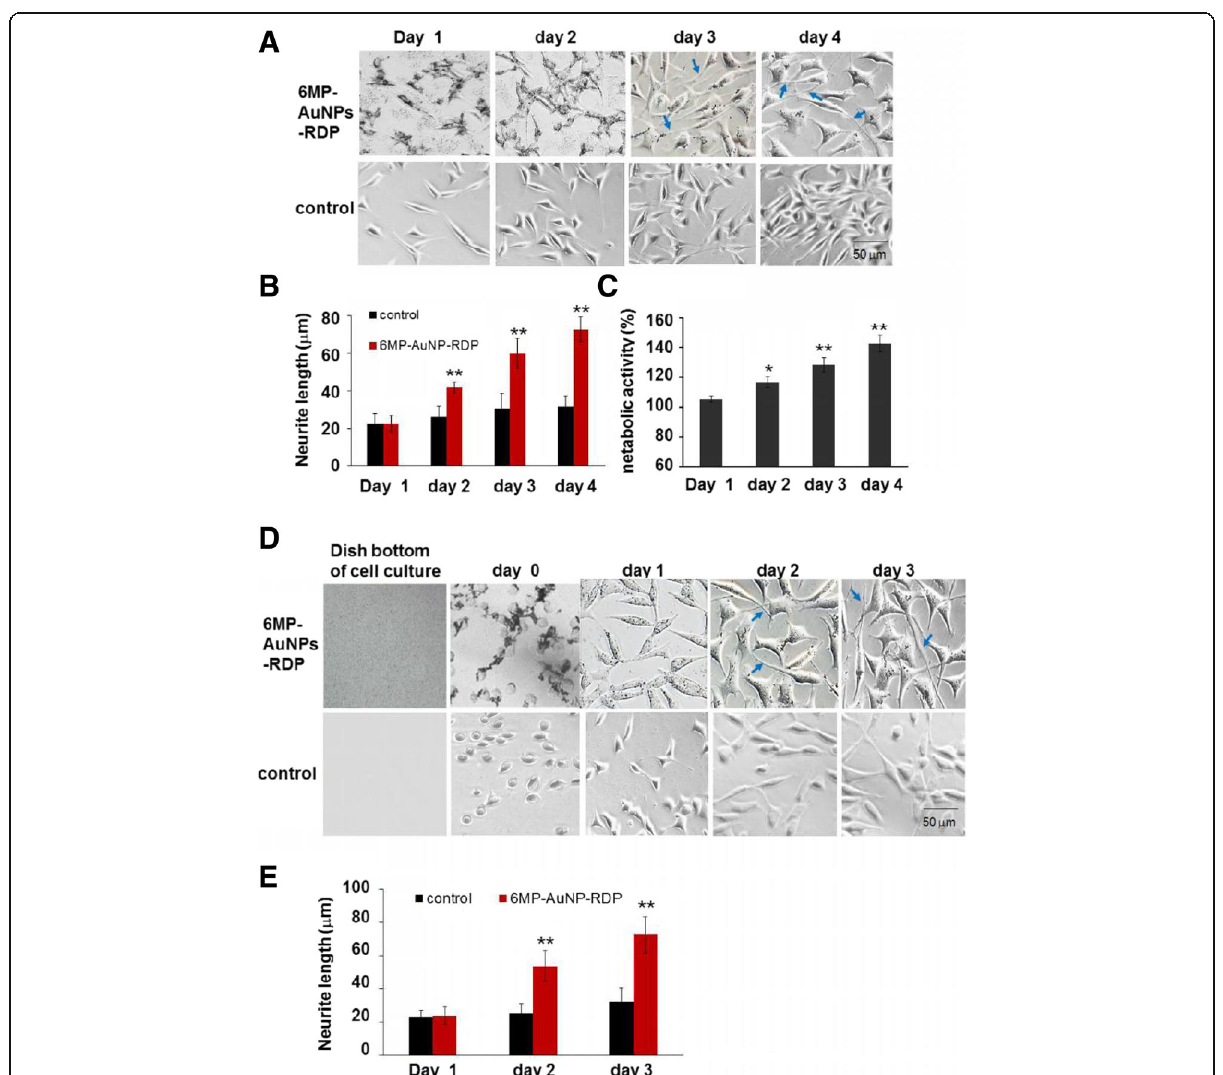
Fig. 6 The nanoparticle induced cell proliferation and neurite growth. a cell images at days 1, 2, 3, and 4. b Neurite lengths of 6MP-AuNPs-RDP- treated cells and the control. The values were averaged for 200 neurites. ** p < 0.01 compared with the control. c Metabolic activity of 6MP-AuNPs- RDP-treated cells. The cells received treatment three times once a day for 3 days. At the first time, 6MP-AuNPs-RDP was added into the cell media after the cells were cultured for 24 h from cell transplantation. Each concentration of the particles was 0.25 μ g/mL. d Images of neurite growth of the cells on surface coating with 6MP-AuNPs-RDP. 6MP-AuNPs-RDP was plated on the bottom of culture dishes of 3.5 cm diameter, and then, the cells were transplanted on the dishes. e The neurite length were measured at 0 ~ 3 days. The cells with only solvent were used as control. The values were averaged for 200 neurites. ** p < 0.01 compared with the control, * p < 0.05, ** p < 0.01 compared with the cells of day 1. The blue